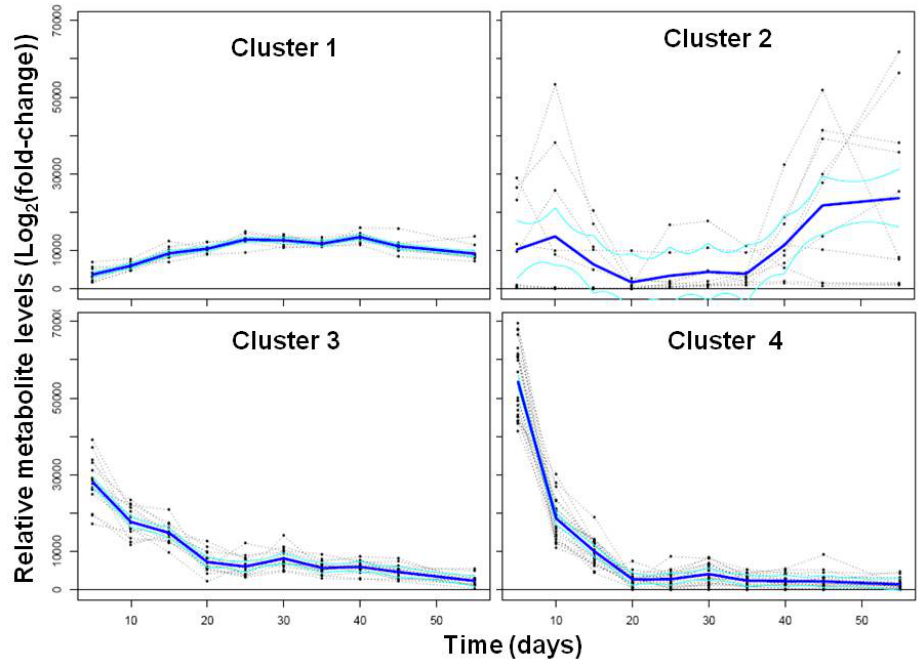
Figure 3. Changes in metabolite levels in developing soybean embryos. Relative metabolite levels obtained from GC-MS-FID and UPLC analyses and protein levels were subjected to Limma computational analysis to obtain trends as described in the Experimental Section. Only metabolites that showed statistically significant changes ( p -value < 0.05) for at least one time point were subjected to SplineCluster analysis resulting in four clusters (shown in the same scale). The levels of homoserine, aconitate, mucic acid, ornithine, and Met did not change significantly over embryo development. Cluster 1 contained 10 metabolites (citrate and nine lipid-derived fatty acids that were detected by GC-FID (Table 1)) and total protein. Cluster 2 contained 10 metabolites (sucrose, oxalate, mannitol, lactobionate, melibiose, galactinol, galactinol-like, raffinose, Arg, 2-aminobutyrate). Cluster 3 contained 16 metabolites (phosphate, malate, pinitol, inositol, ethanolamine, myo-inositol, maltose, Gly, Asp, Glu, Thr, Ala,  -aminobutyrate, Pro, Lys, Tyr). Cluster 4 contained 22 metabolites (fructose, glucose, glycolate, malonate, succinate, glycerate, fumarate, beta-cyanoAla, pyroGlu, 4-guanidinobutyrate, putrescine, dehydroascorbate, saccharate, His, Asn, Ser, Gln, citrulline, Val, Ileu, Leu,